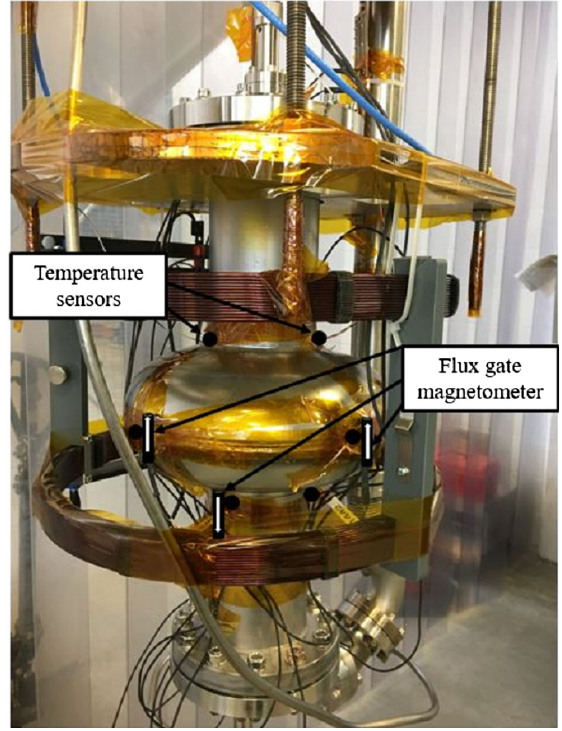
FIG. 2. Experimental set up of the single-cell cavity with Helmholtz coils, flux-gate magnetometers, and Cernox sensors.